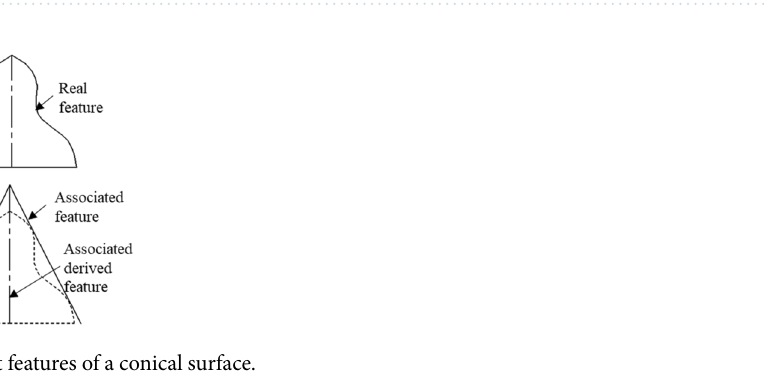
Figure 2. The exploded view of a hydraulic equipment.